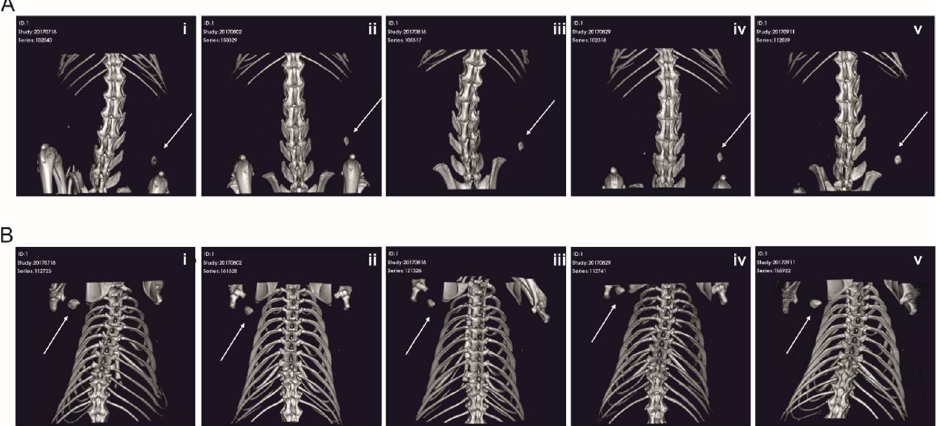
Figure 4. Evaluation of ectopic bone formation in a rat subcutaneous model. Representative micro- CT images of one rat out of the four rats treated with 10 µg ( A ) BMP2 WT adsorbed to RCP and ( B ) covalently coupled BMP2 Azide. ( i ) 4 weeks, ( ii ) 6 weeks, ( iii ) 8 weeks, ( iv ) 10 weeks and ( v ) 12 weeks. The arrows indicate the subcutaneously formed ectopic bone.